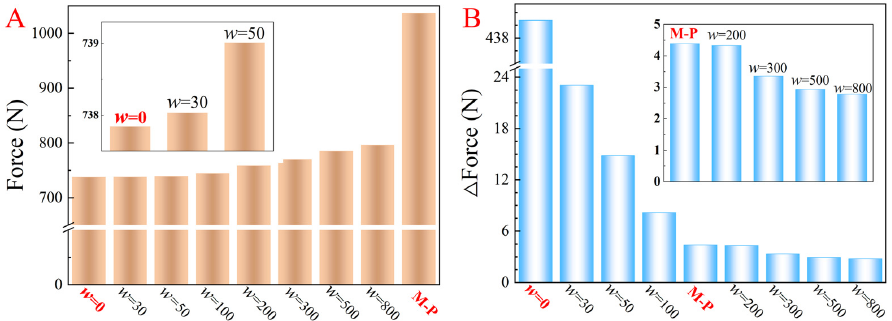
Figure 13. The entire trajectory’s simulation results of MCPM( M = 2, N = 2) using different optimization methods: ( A ) maximum driving force and ( B ) maximum driving force mutation.